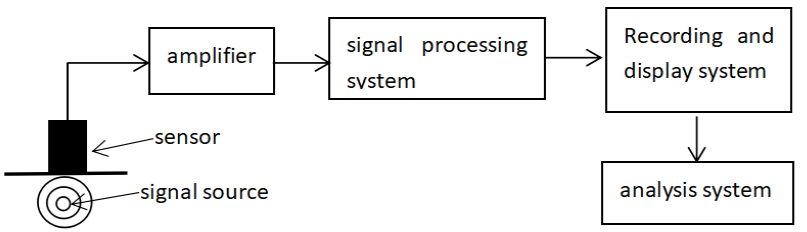
Figure 1. Acoustic emission acquisition principle.